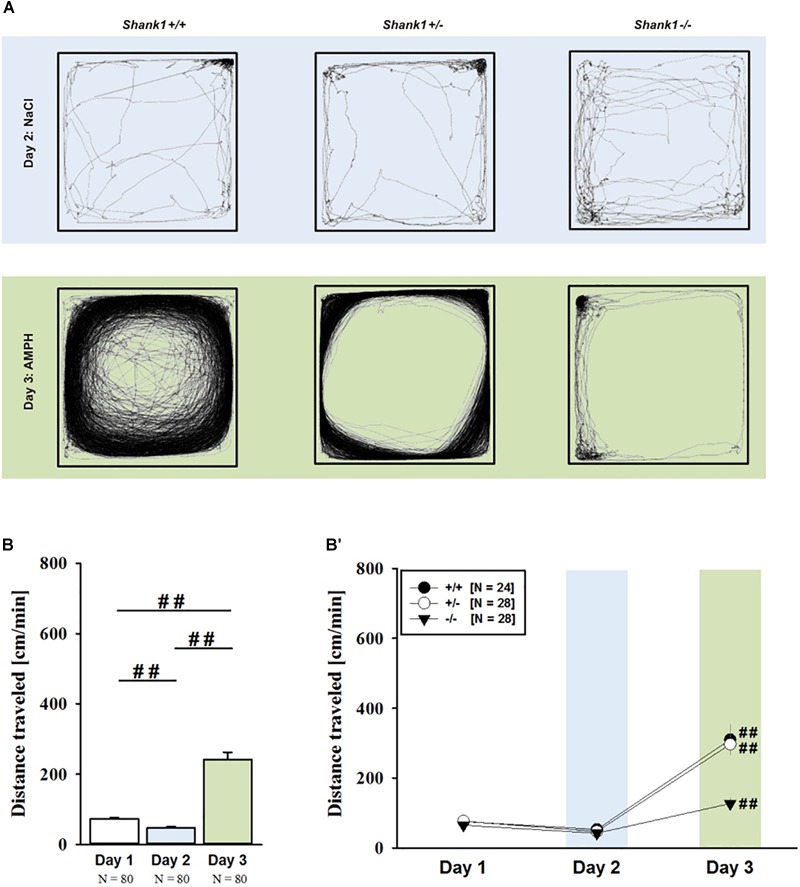
(A) AMPH-induced hyperactivity in adult Shank1 mice. Exemplary figure depicting the locomotor activity pattern of individual adult Shank1+/+, Shank1+/-, and Shank1-/- mice injected with saline (NaCl) on day 2 (upper panel) and with AMPH on day 3 (lower panel); measured over 45 min. (B) Bar graph depicting the distance traveled by all genotypes during baseline testing (white bar), following saline administration (blue bar), and after AMPH treatment (green bar). (B′) Line graph depicting the distance traveled by Shank1+/+ (black circle), Shank1+/- (white circle), and Shank1-/- (black triangle) over the three consecutive test days. Data are presented as means + SEM or means ± SEM. ##p < 0.001 (B), ##p < 0.001 vs. day 2 (B′).